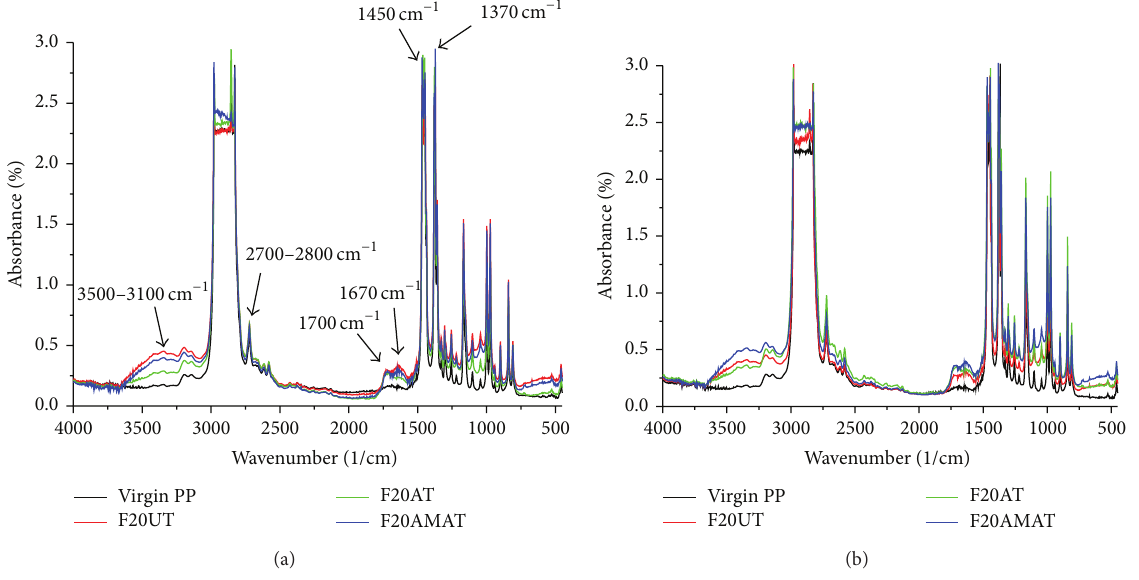
Figure 1: FTIR spectra of the PP/alfa fiber composites: (a) before aging and (b) after